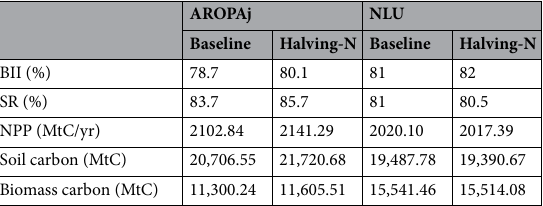
Table 4. Annual mean biodiversity and carbon values across the European Union